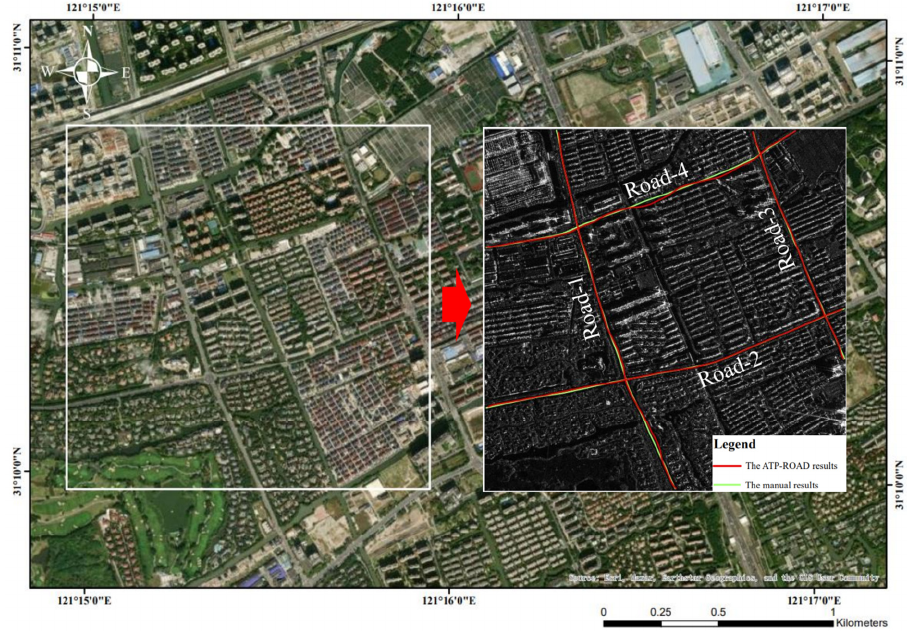
Figure 9. The extracted roads of Area-I overlaid the SAR image where the background map is a GeoEye multispectral image.